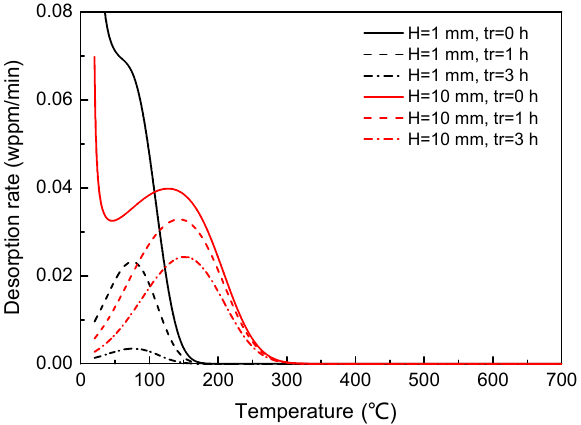
Figure 4. Simulated desorption spectra with different specimen geometries (H = 1, 10 mm) and rest time ( t r = 0, 1, 3 h), showing the faster escape of hydrogen for smaller specimen. Both peak temperature and peak flux are strongly affected due to the change in specimen geometry. The heating rate was fixed at 200 K/h.